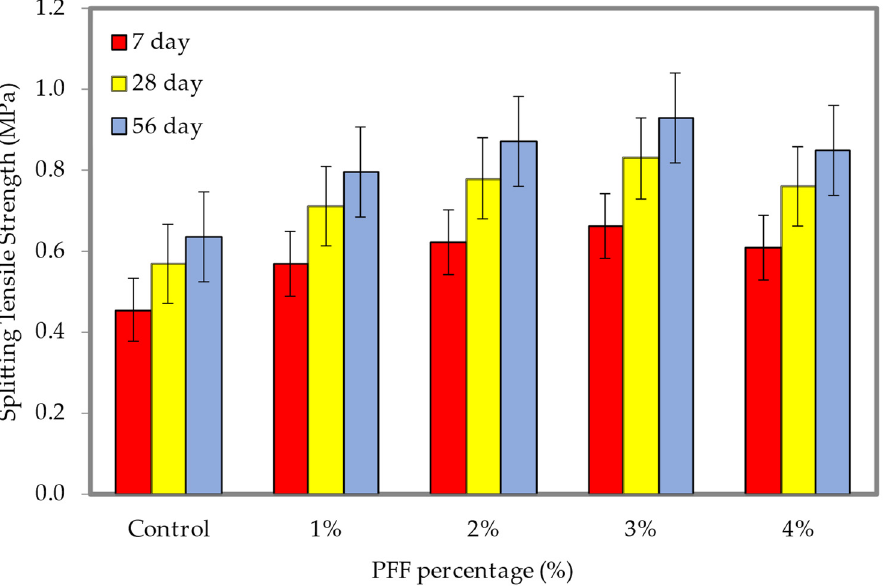
Figure 19. Splitting tensile strength of foamed concrete of 1200 kg/m 3 density with varying PFF per- centages.